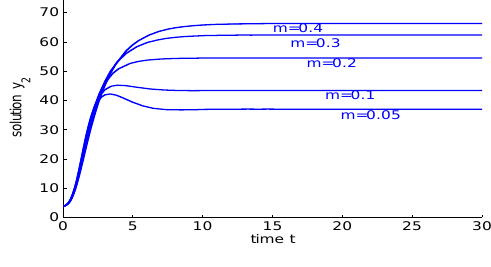
Figure 12: τ = 0 , E * is locally asymptotically stable. Change the values of the refuge m from zero to 1 − R 1 = 0.4432 , the predator species will increase.